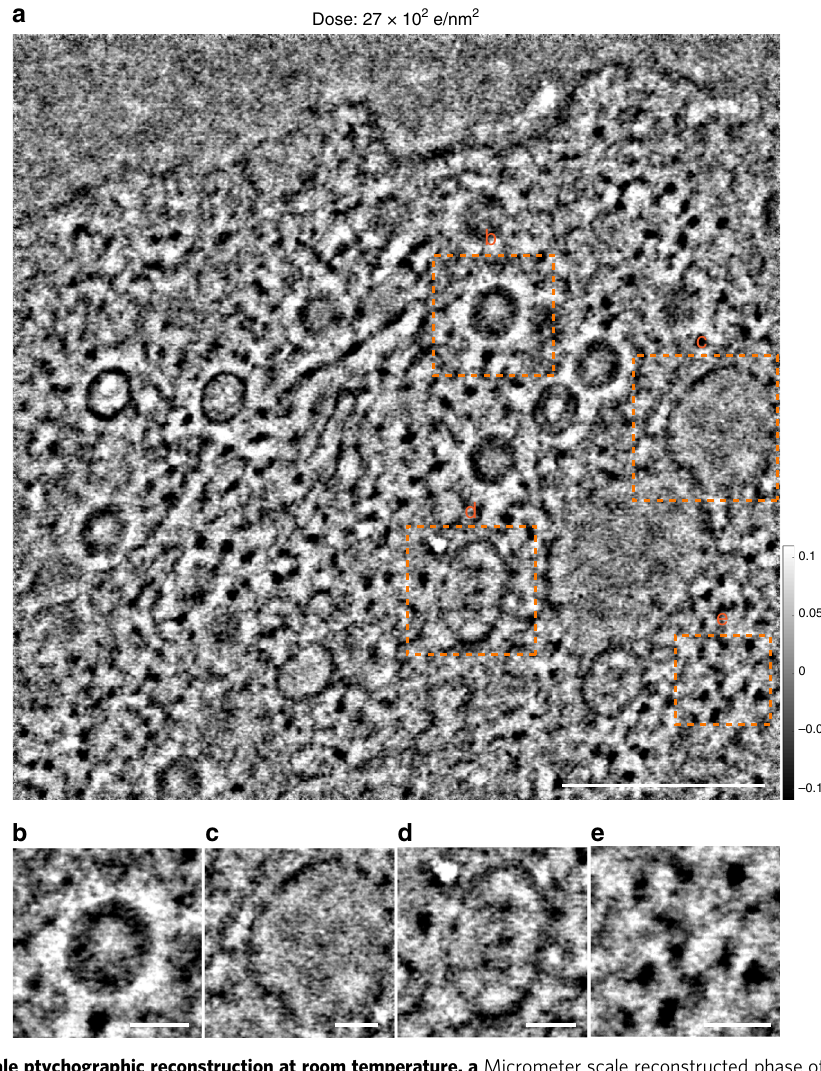
Fig. 4 Low-dose large scale ptychographic reconstruction at room temperature. a Micrometer scale reconstructed phase of an Adenovirus-infected cell recorded at a dose of 27 e/Å 2 . Magni fi ed views of b a viral particle, c a vacant vesicle. d A transport vesicle and e free ribosomes taken from regions indicated with orange squares in a . Scale bars are a 300 nm, and b – e 50